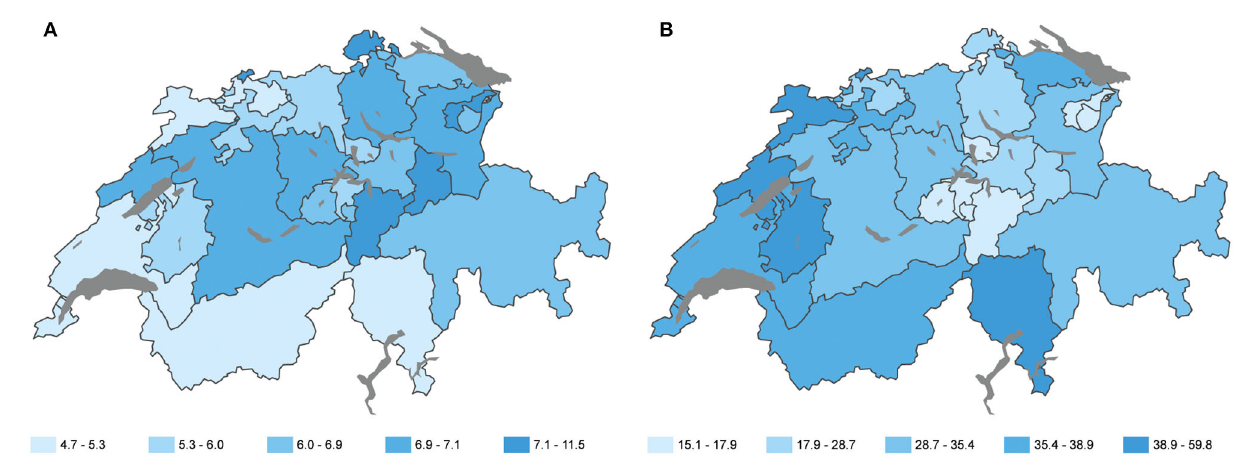
FIGURE 1 | Nursing home places and use of ambulant long-term care in the language regions. (A) Number of nursing home places per 1,000 individuals 65 years old and more. (B) Number of people using ambulant home care (SPITEX) per 1,000 individuals in the cantons of Switzerland 2016 (Swiss Health Obervatory, 2021; reprinted with permission by Swiss Health